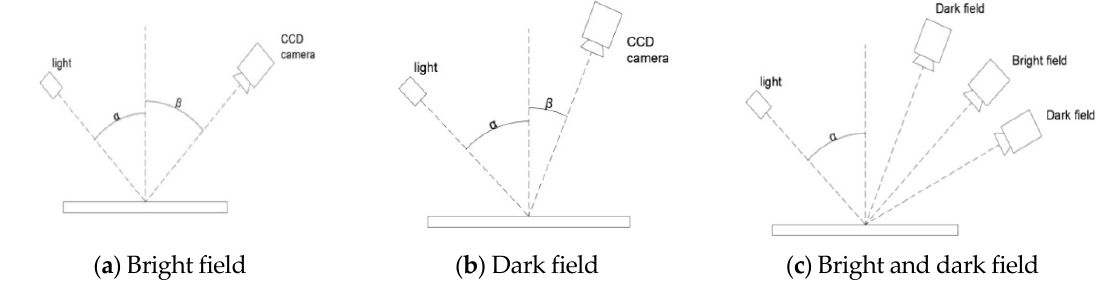
Figure 5. Lighting methods.